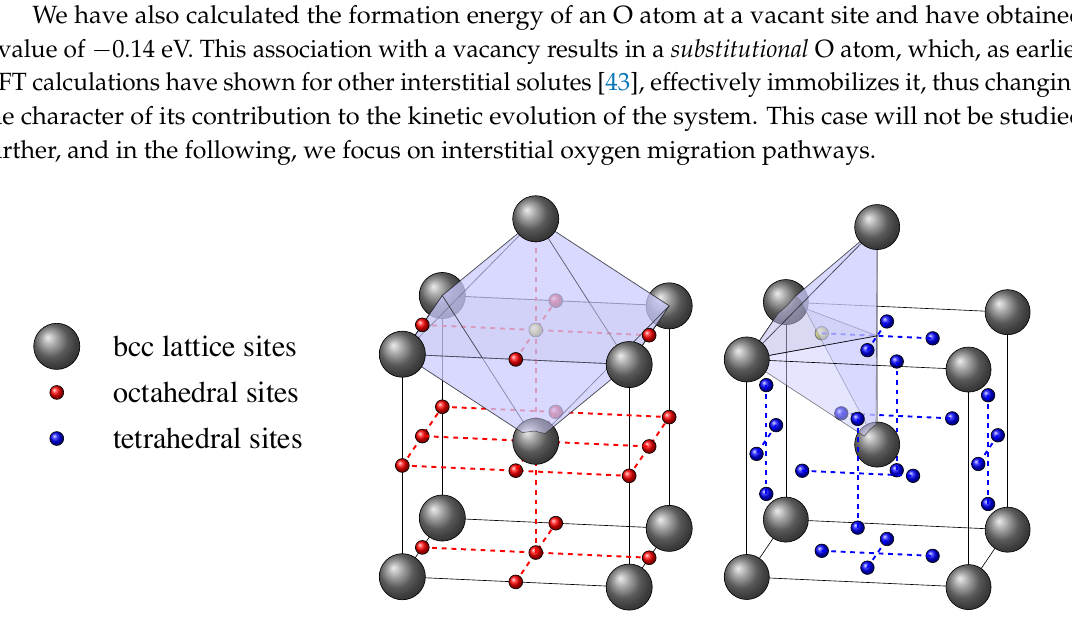
Figure 3. Elementary bcc lattice cell showing octahedral and tetrahedral interstitial sites. As a guide to the eye, the figures show a shaded octahedron and tetrahedron with the interstitial site highlighted in their respective centers. In principle, transitions may occur between any two nearest neighbor interstitial sites.